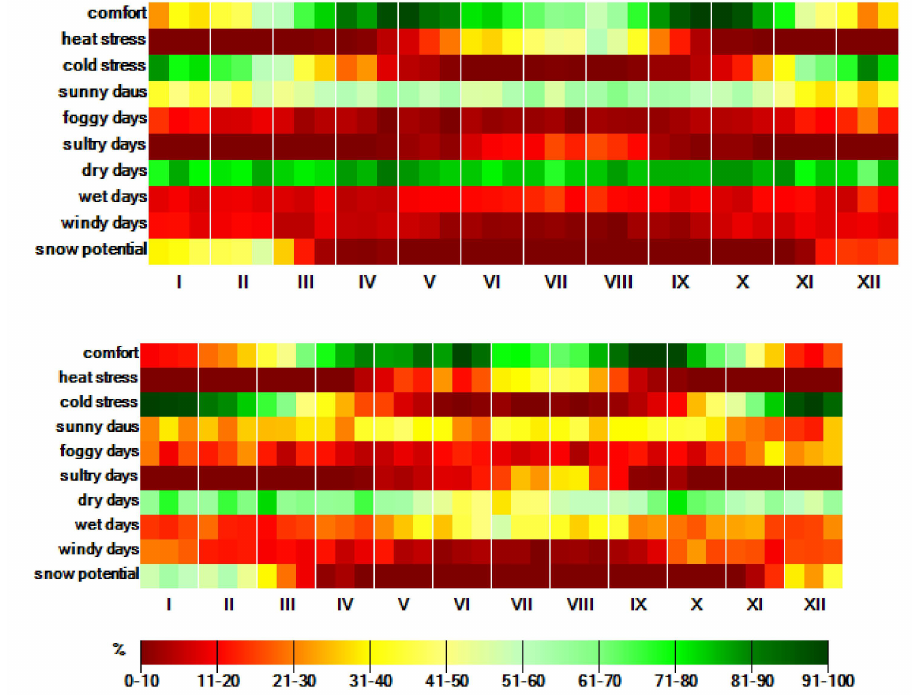
Figure 13. CTIS in Długople-Zdr ó j for anticyclonic (top) and cyclonic (bottom) types of circulation in